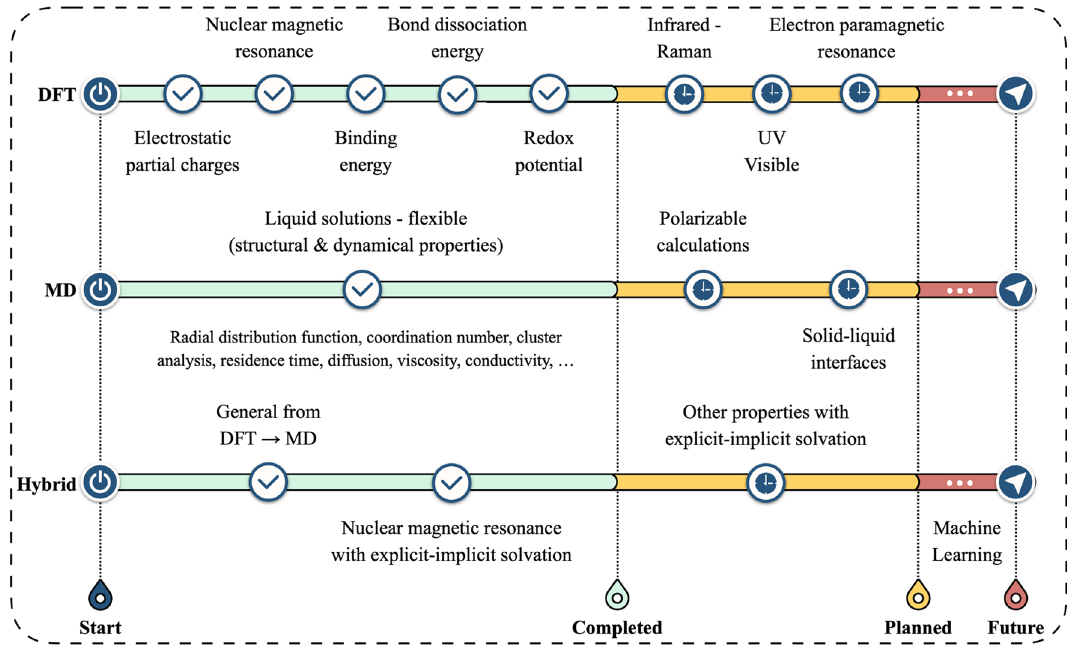
Figure 2. Roadmap of existing and planned workflows in MISPR.